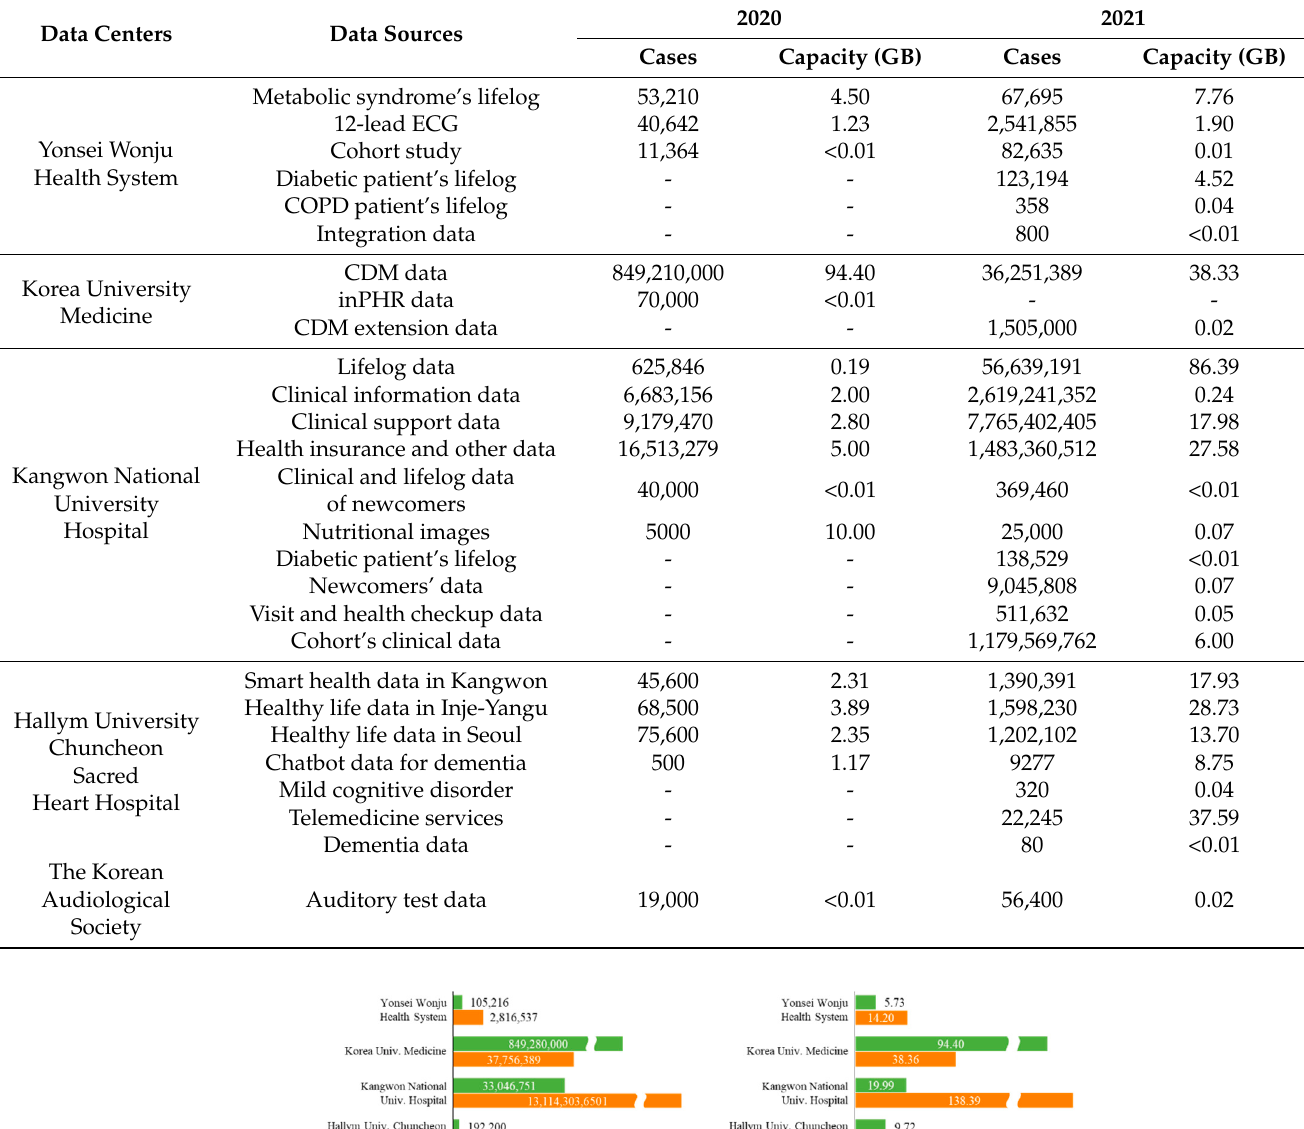
Table 2. The dataset list of medical data centers.